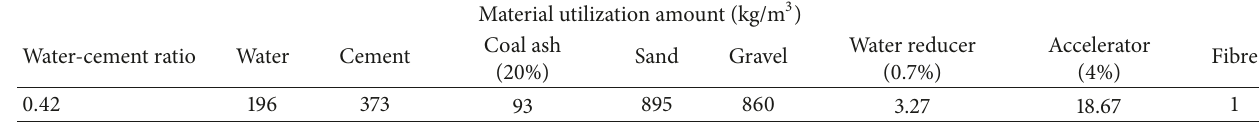
Table 3: Experimental concrete mix